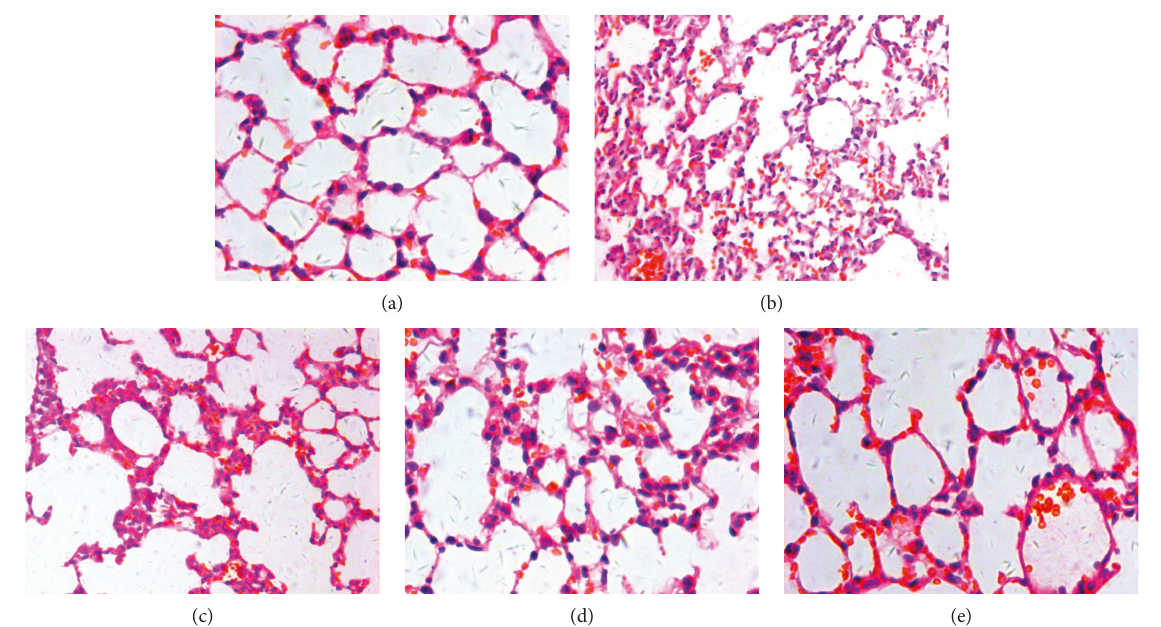
Figure 3: E ff ect of anti-IL-5 mAb and ABPS, respectively, or combined treatment on airway in fl ammation (H&E, magni fi cation × 100). Exposure to HDM increases airway in fl ammatory cell in fi ltration and treatment decreased it, which is more remarkable in the anti-IL-5 mAb and ABPS combined treatment group. (a, b, c, d, e) represents control, asthma group, ABPS group, anti-IL-5 and anti-IL-5 mAb, and ABPS combined group,